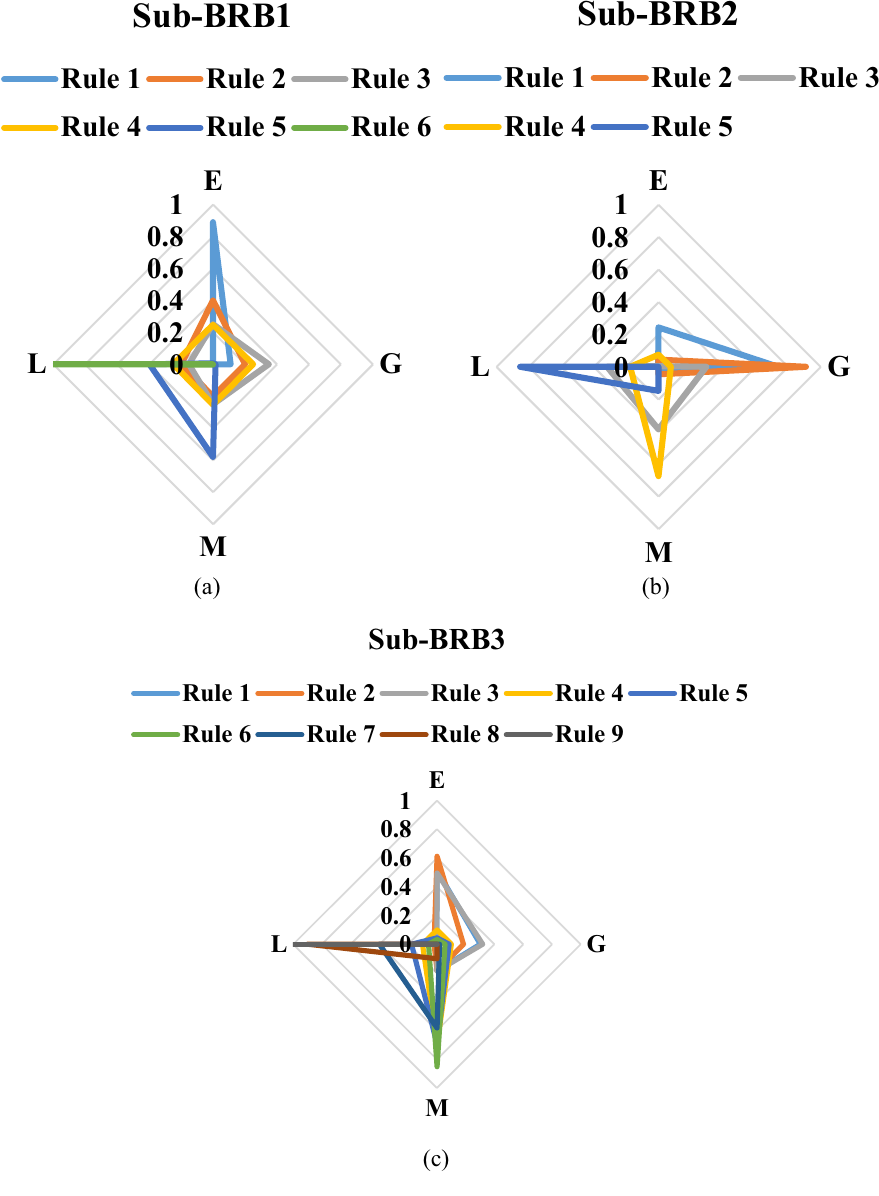
Figure 28. Belief distribution of each rule of